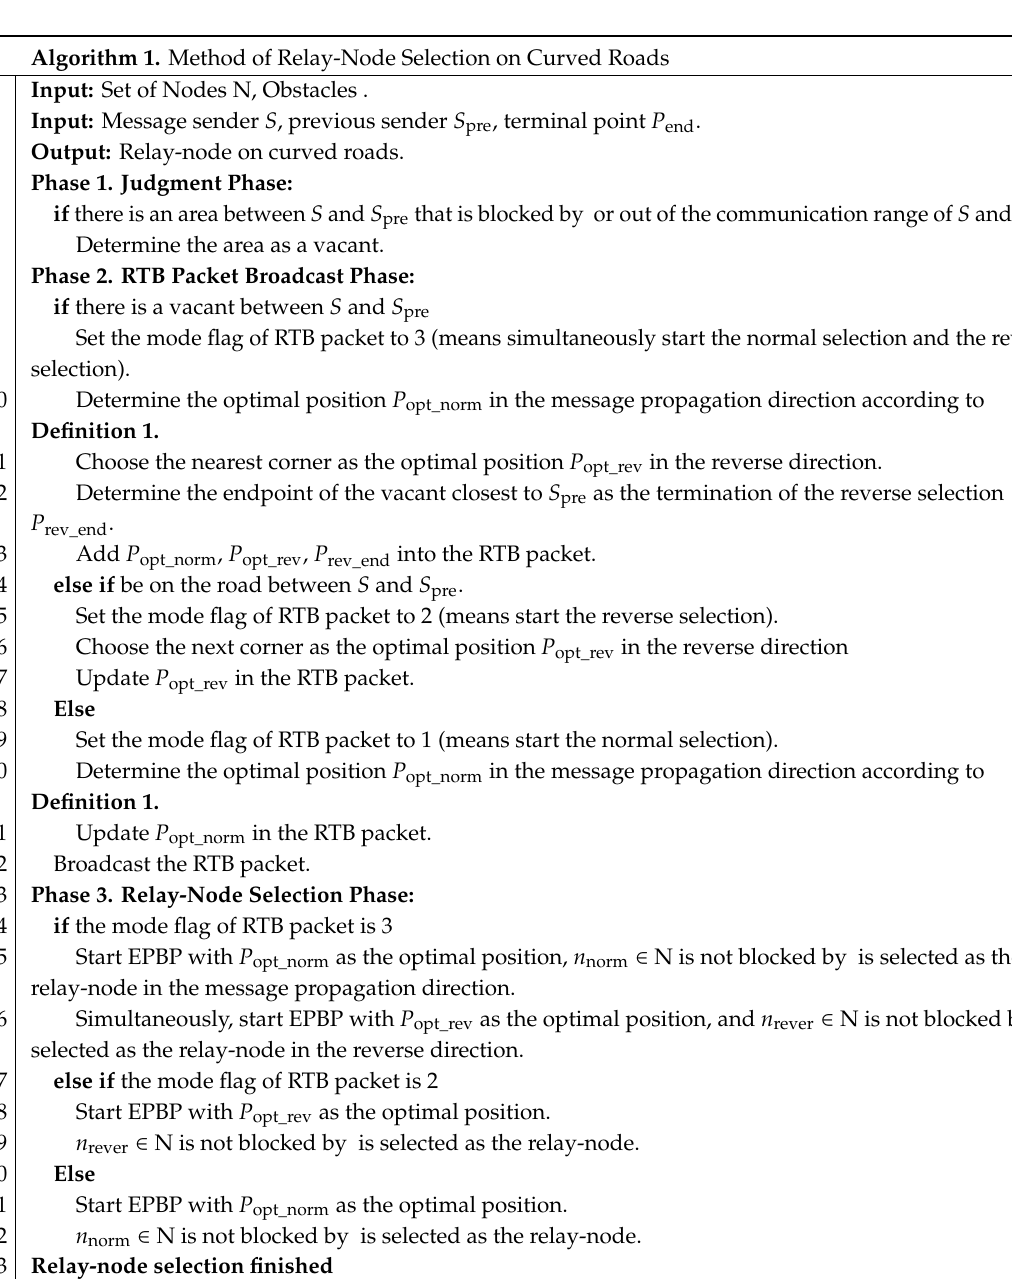
Algorithm 1. Method of Relay-Node Selection on Curved